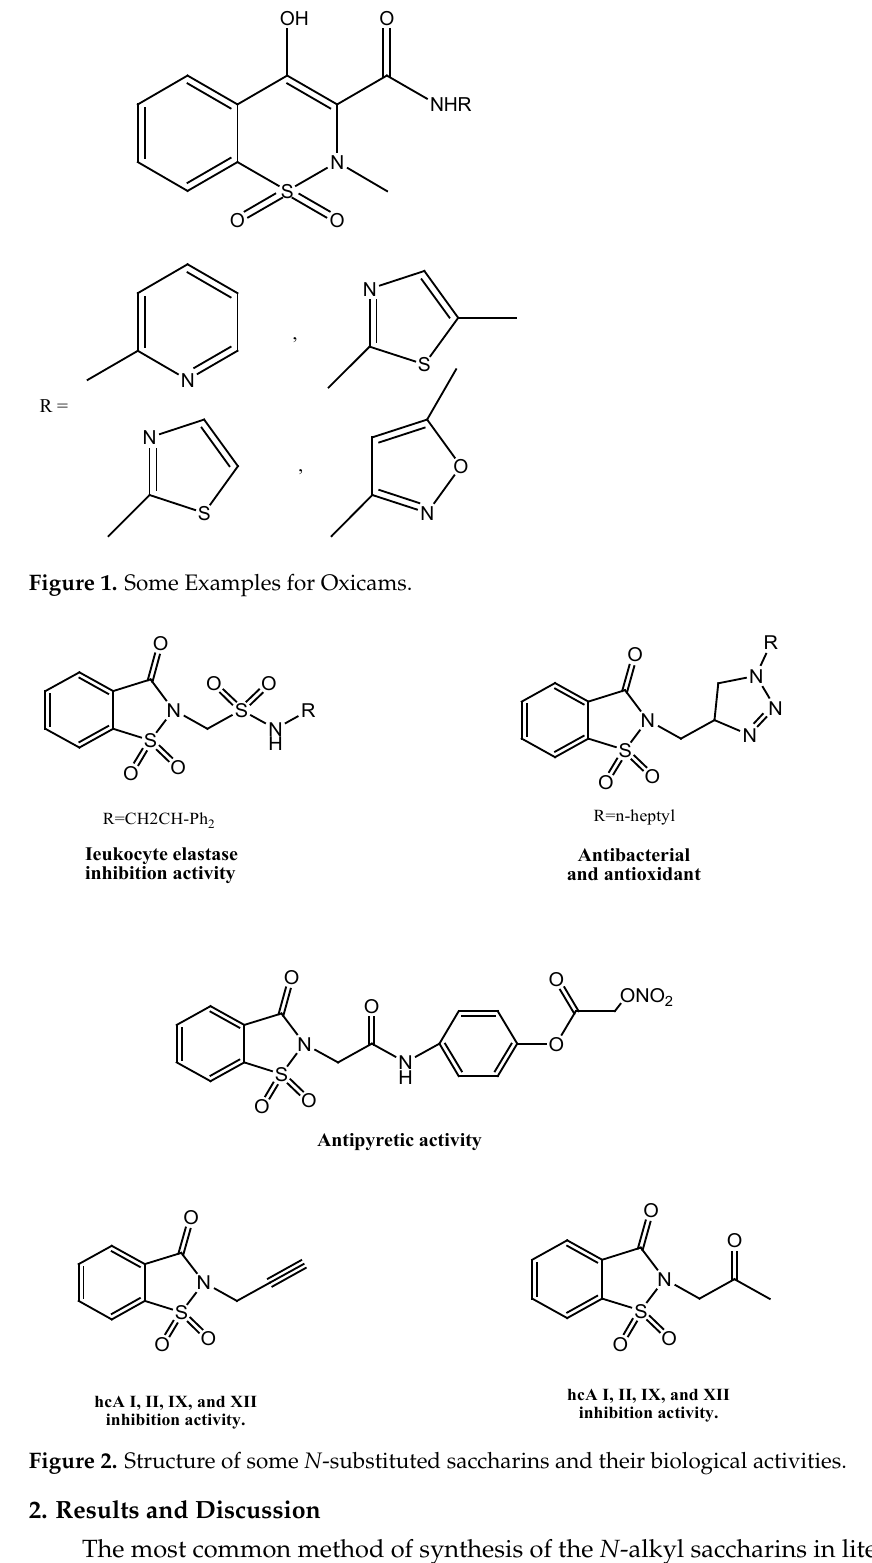
Figure 2. Structure of some N -substituted saccharins and their biological activities.